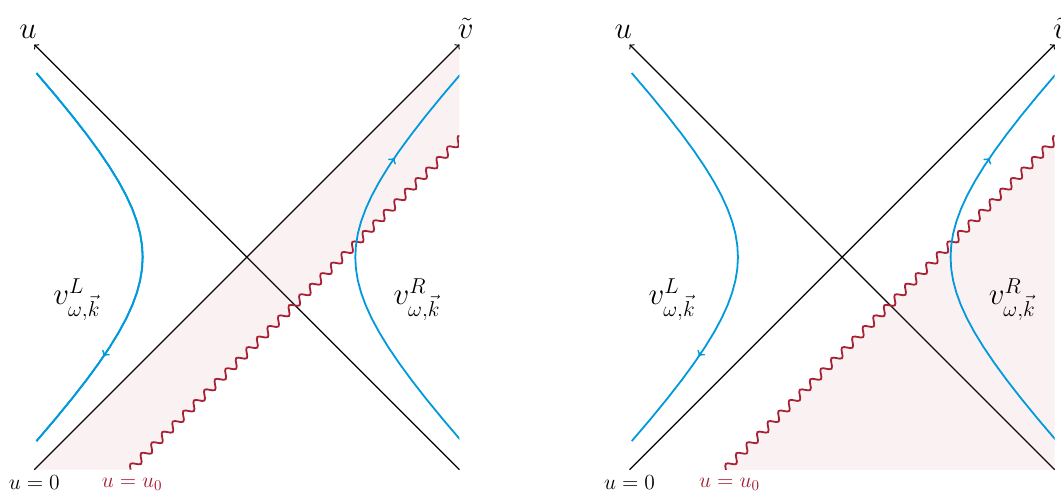
1 Figure 2 . Schematic depiction of the construction of the right Rindler modes. The left picture depicts the case where one starts out with the standard Rindler modes in the region u < u 0 and then propagates the solution using the free wave equation for 0 > u > u 0 . The right one shows the construction starting with the standard Rindler modes in the region 0 > u > u 0 and then use the free wave equation to propagate the solution backwards for u < u 0